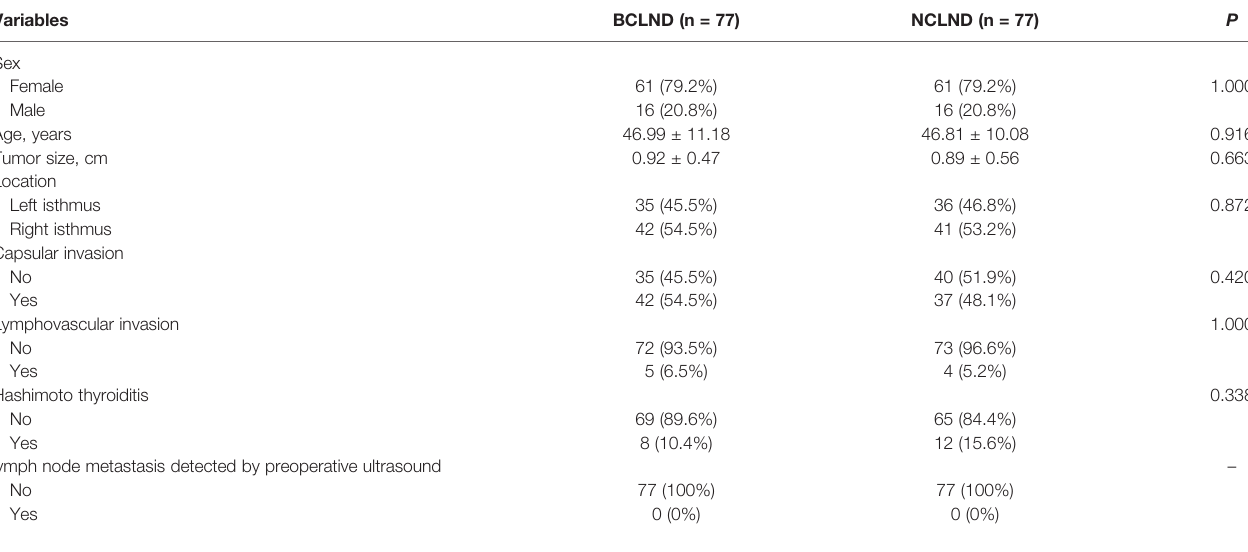
TABLE 2 | Baseline clinicopathological characteristics of patients with PTC located at isthmus with BCLND or NCLND after propensity score matching. Variables